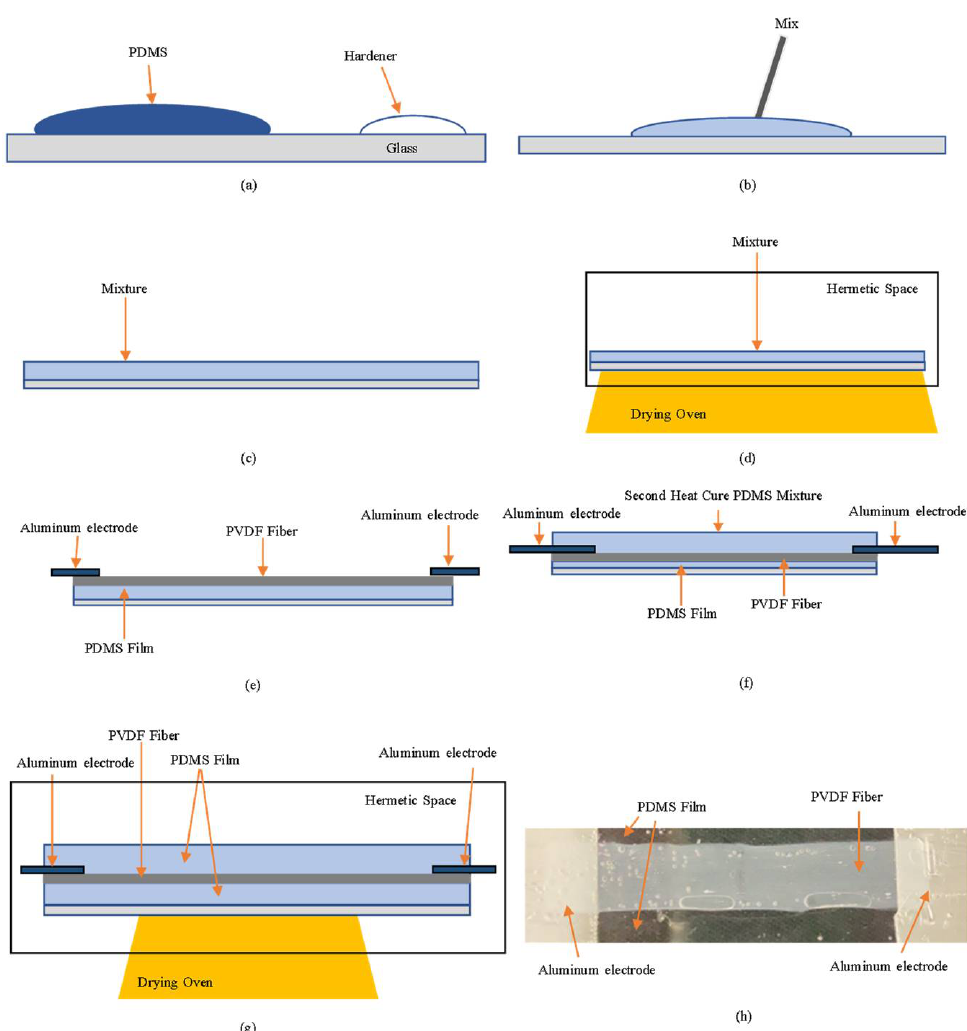
Figure 5. ( a ) PDMS and curing agent are formulated at a ratio of 10:1; ( b ) Thoroughly stir with a stirring bar; ( c ) Pour on the glass and wait for the bubbles to evaporate; ( d ) Put into an oven and perform closed heating in parallel. The temperature is 110 ◦ C; ( e ) PVDF fiber film is laid out on PDMS film. Aluminum electrodes are attached to both ends of the PVDF fiber film; ( f ) Repeat steps ( a , b ), then pour the mixture over the element from ( e ); ( g ) Put into an oven and perform closed heating in parallel. The temperature is 40 ◦ C; ( h ) Actual diagram of self-powered strain